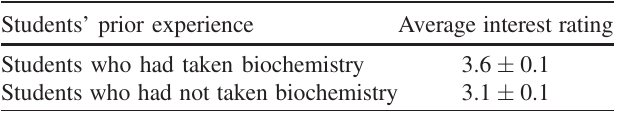
TABLE III. Students ranked their interest in the “ dielectric constant ” topic differently, depending on whether or not they had encountered the topic in their biochemistry course. Average five- point Likert-scale ratings and standard errors are shown for the IPLS course (Years 1 – 4, N ¼ 194